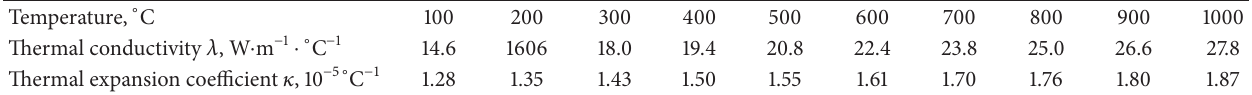
Table 1: Heat conductivity and expansion coefficient under different temperature (reference 20 ∘ C).